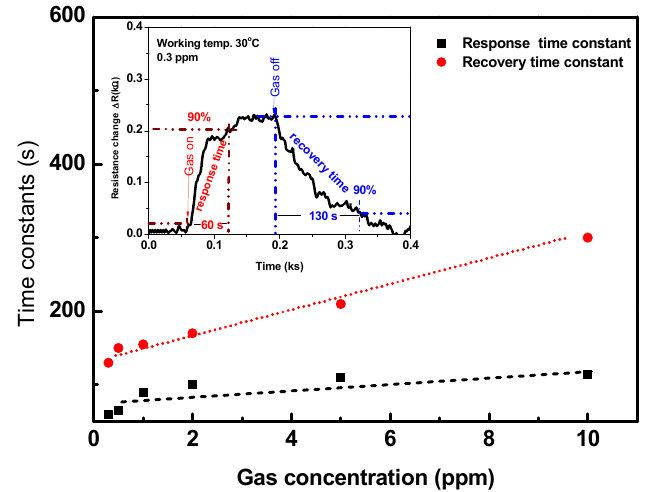
Figure 10. The response and recovery time constants as a function of gas concentration calculated from device signal measured at 30 °C. The inset shows the method for calculating the response and recovery time constants.